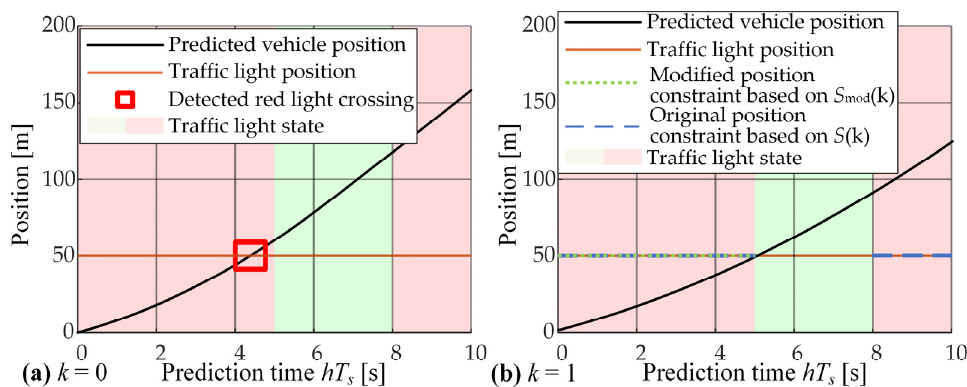
Figure 2. Illustration of construction of time-dependent only traffic light position constraint in current time step ( b ) based on vehicle position trajectory predicted in previous step ( a ).